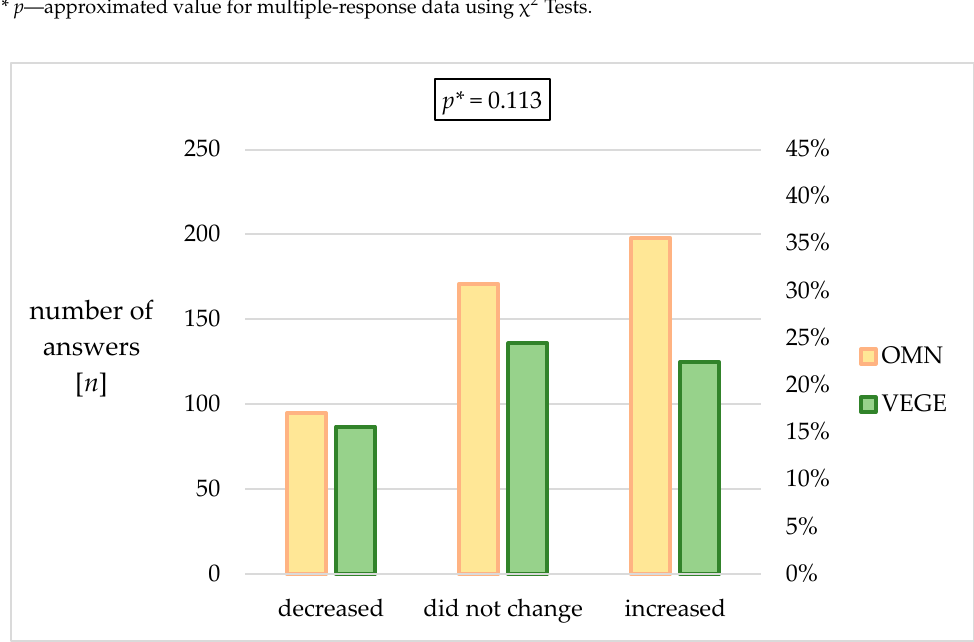
Figure 2. Changes in weight of the responders during the pandemic. * p —calculated between the studied groups using χ ² Tests.